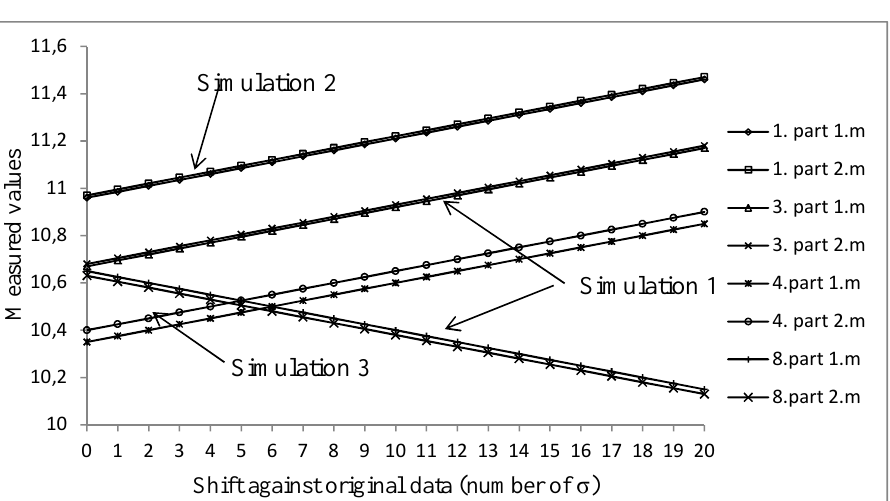
Figure 1 The changes of the measured values for all three simulations. Table 2 Results of Simulation 1 for A&R and ANOVA